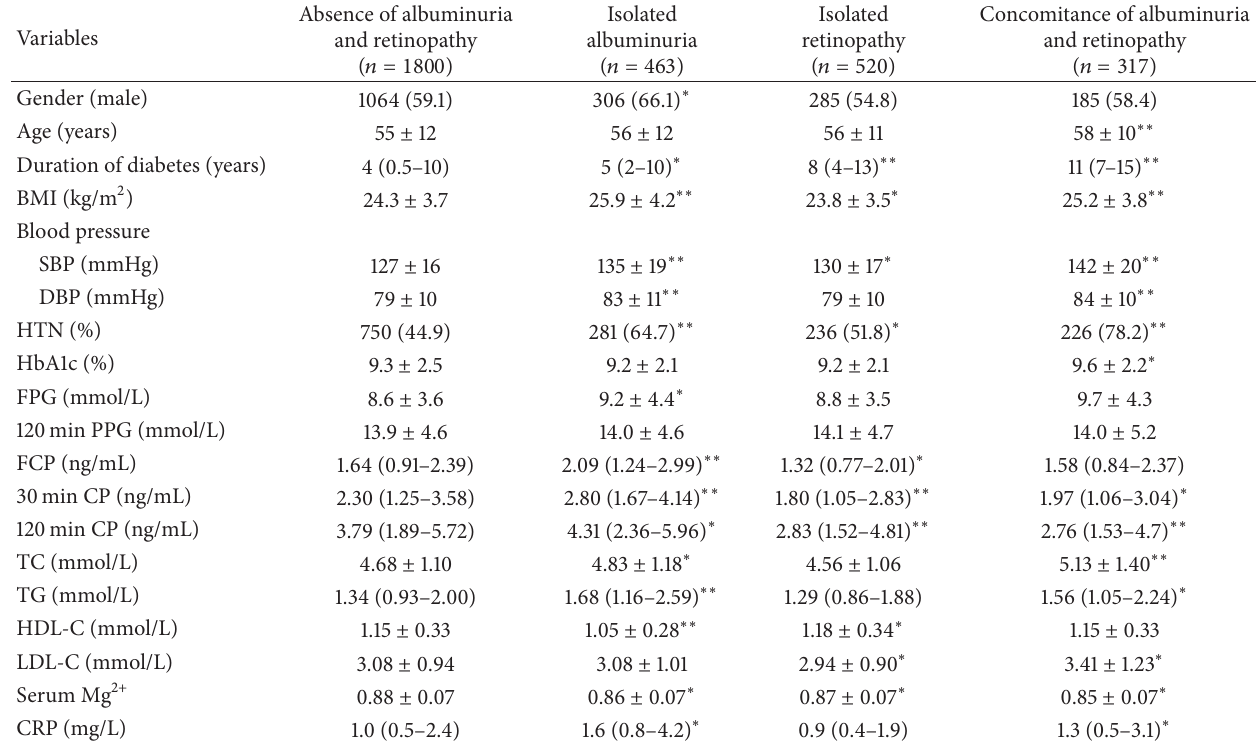
Table 1: Clinical characteristics of patients with and without albuminuria and diabetic